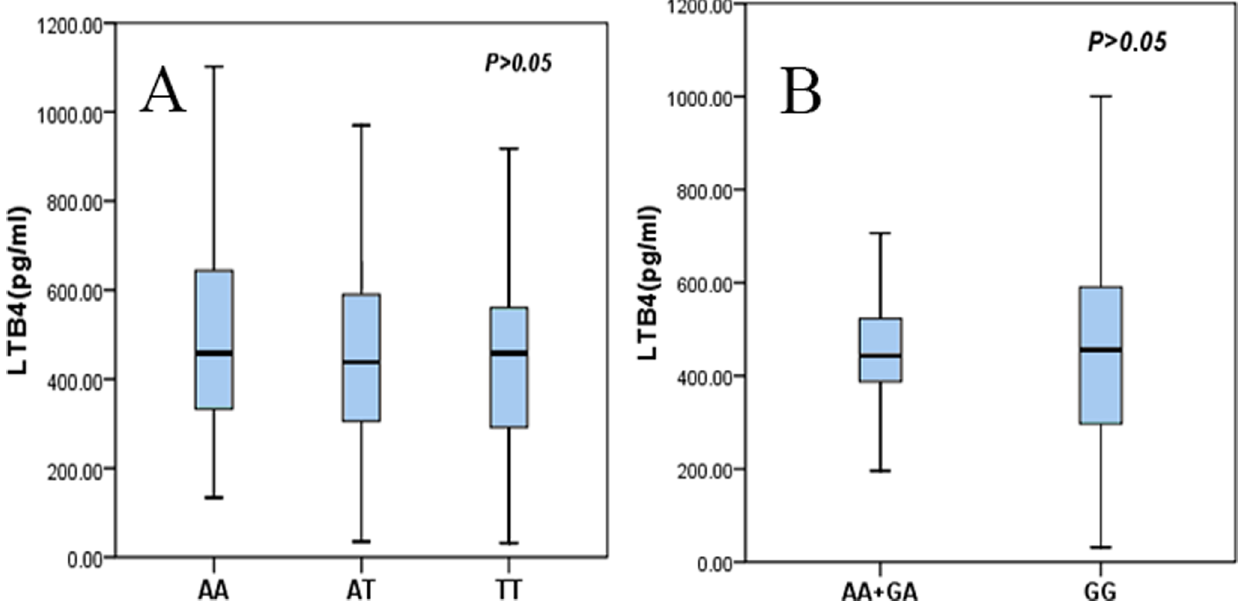
Figure 6. Plot box of serum LTB4 levels (pg/ml) among ALOX5AP genotypes in ACS patients. (A) Serum LTB4 level was similar among AA, AT and TT genotype of rs10507391. (B) Serum LTB4 level also was similar between (AA + GA) and GG genotype of rs4769874.